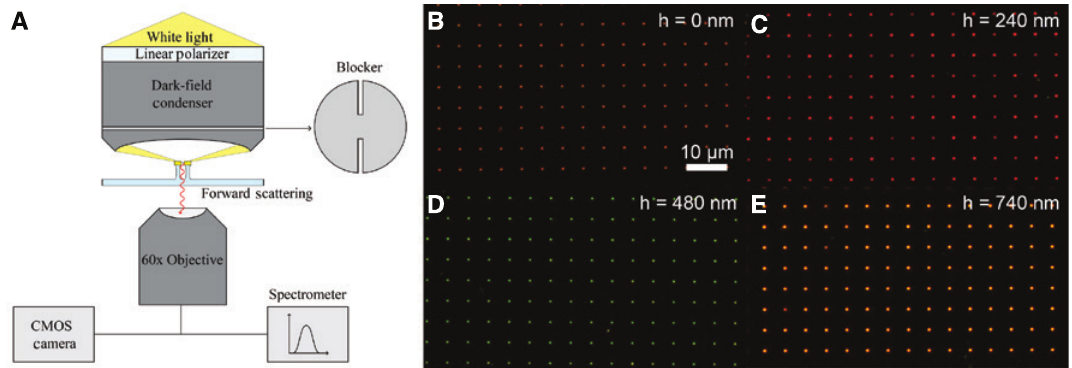
Figure 2: Optical dark-field setup employed to measure scattering of nanopillar dimers. (A) Schematic of the individual elements of the setup. Forward scattered light is sent either to a CMOS camera for imaging or a spectrometer for scattering analysis. (B)–(E) Dark-field images of nanoantenna dimers without pillars and with 240 nm, 480 nm, and 740 nm tall pillars. A clear change in color can be observed with increasing